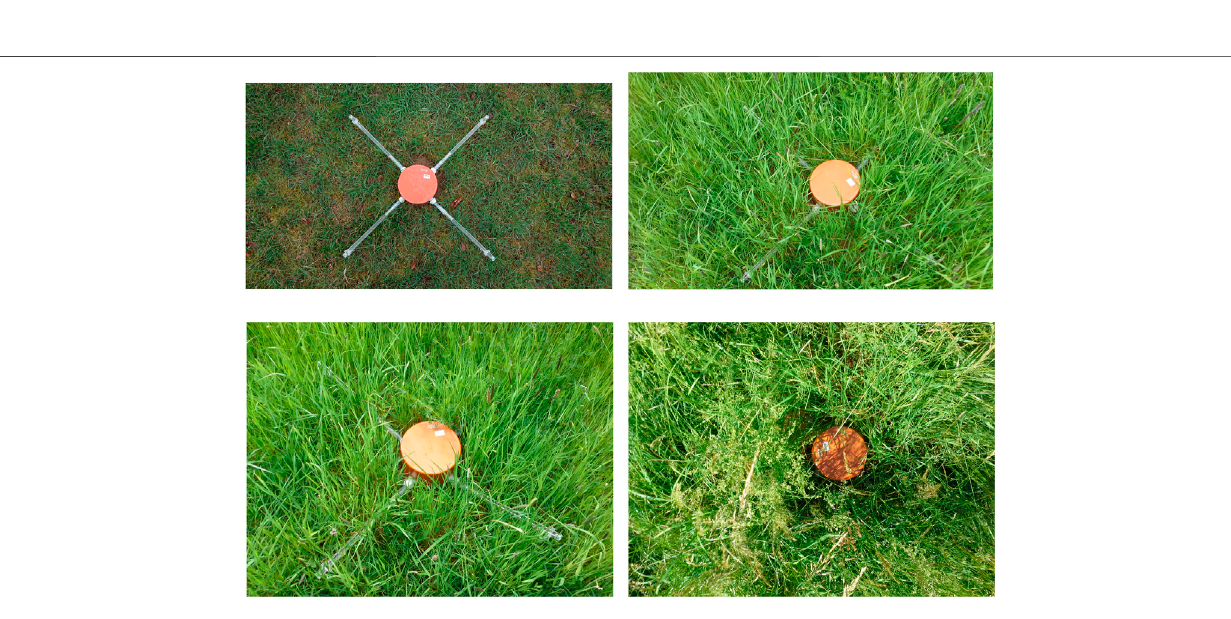
Frontiers in Earth Science |